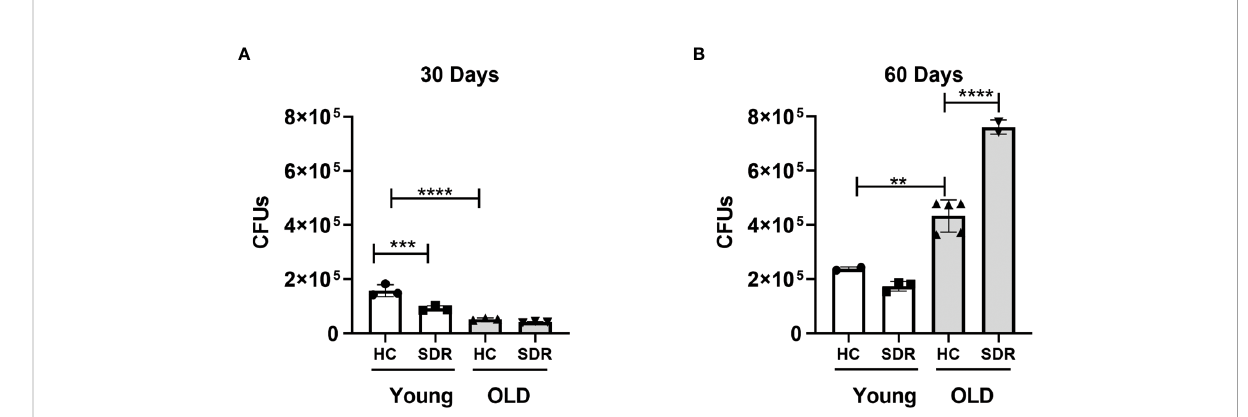
FIGURE 4 Old mice initially control M.tb infection better than young mice but eventually lose control of M.tb infection, which is further exacerbated by SDR. Young and old Home Cage mice subjected to six cycles of SDR were infected with low dose aerosol of M. tuberculosis . At 30 days (A) and 60 days (B) , the left lung lobes were homogenized and M. tuberculosis CFUs enumerated by plating on 7H11 duplicate plates. Results are representative of two independent experiments with 3 mice/group per time point. Data are shown as mean ± SE. Statistical analysis was performed by one-way ANOVA with Tukey multiple-comparisons post hoc test. ** p < 0.01, *** p < 0.001, **** p <